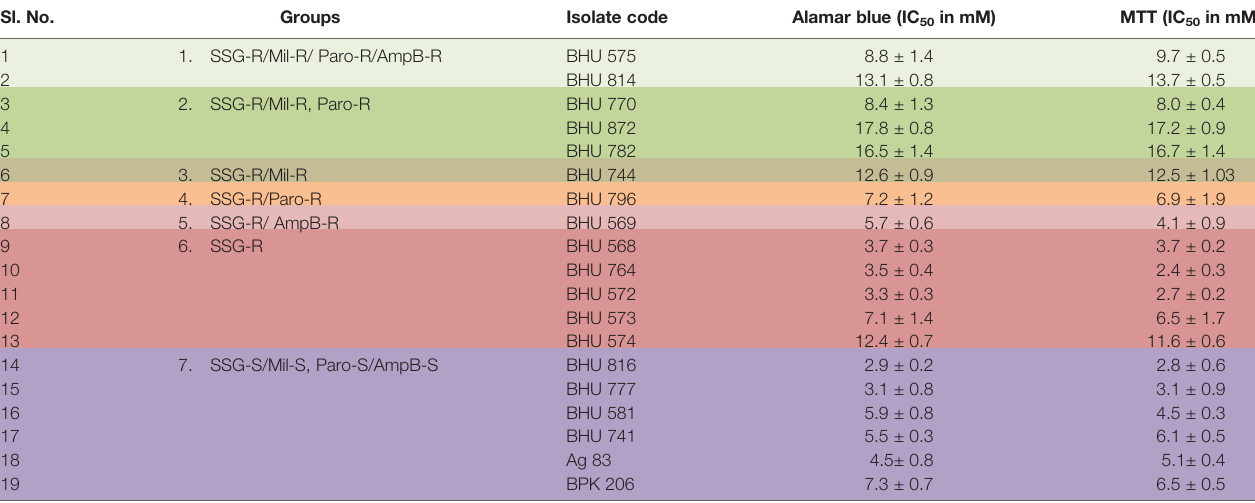
TABLE 2 | Determination of IC 50 against Miltefosine using MTT and Alamar Blue cell viability assay. Sl.